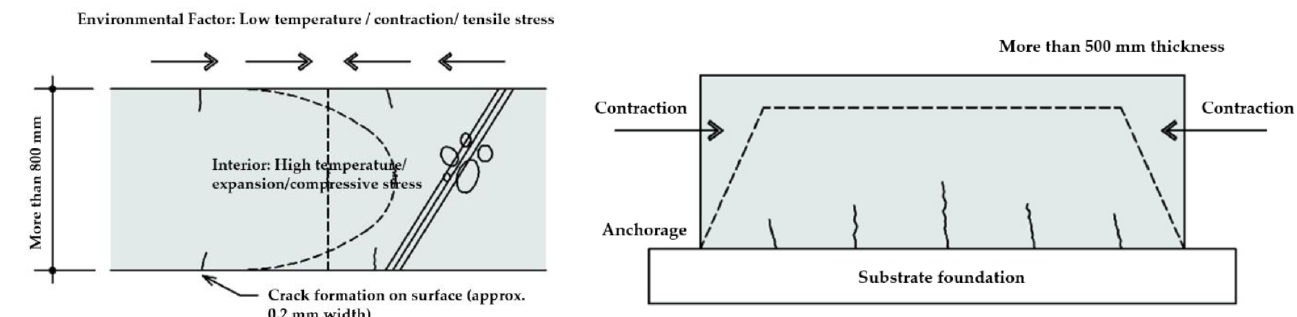
Figure 4. Effects on concrete substrate due to mechanical